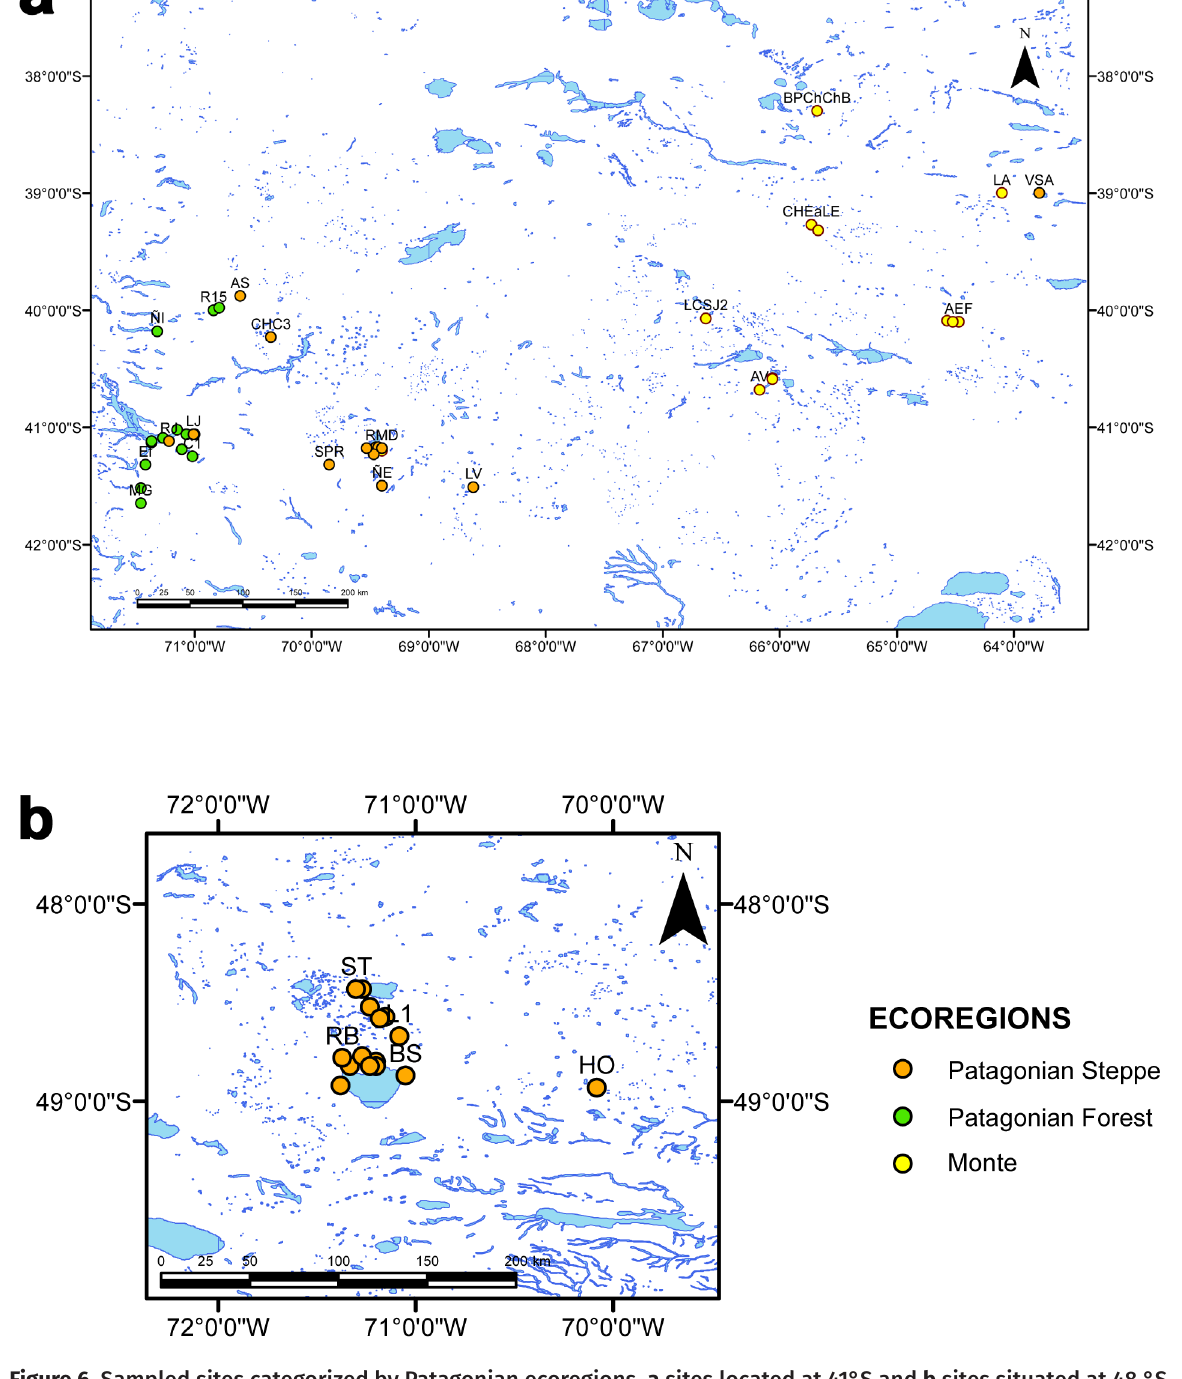
Figure 6. Sampled sites categorized by Patagonian ecoregions, a sites located at 41°S and b sites situated at 48